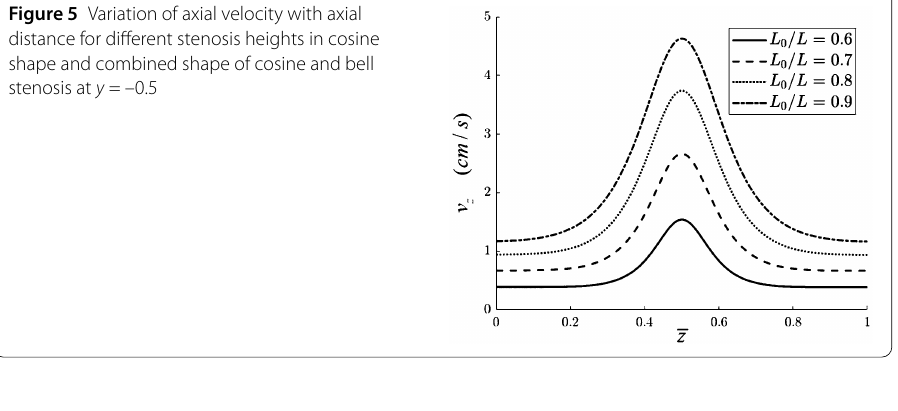
Figure 6 Variation of axial velocity with radial distance for different stenosis lengths in bell shape stenosis at ¯ z =